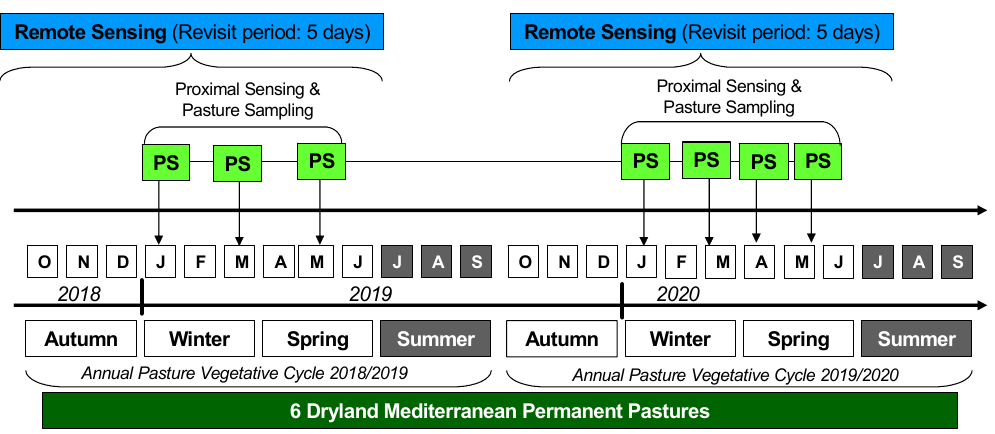
Figure 1. Schematic representation of the methodology used in this work to monitor pasture quality through remote and proximal sensing.